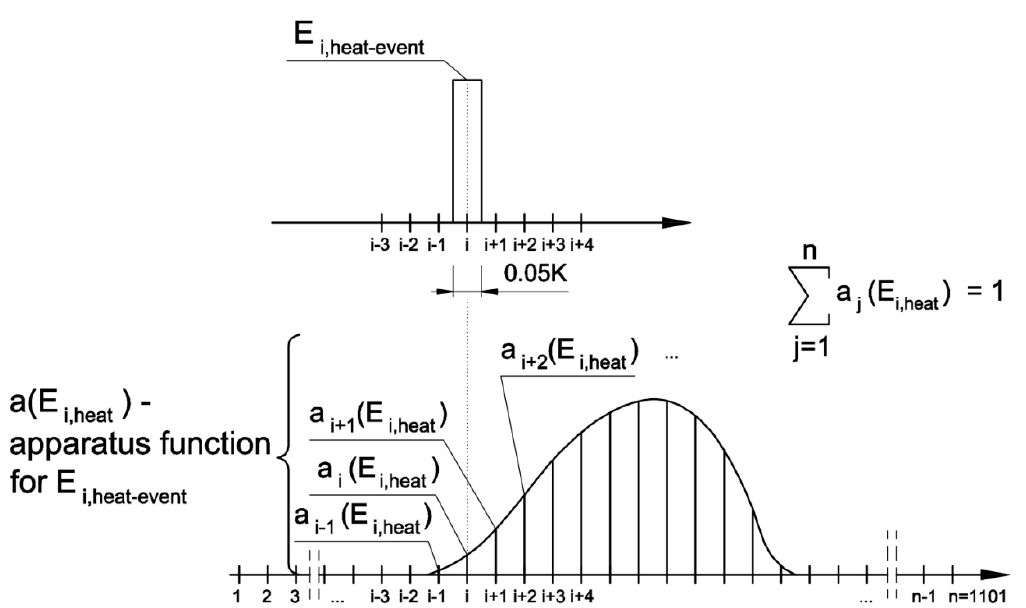
Figure 8. Apparatus function for the single thermal pulse E i,heat ‐ event .